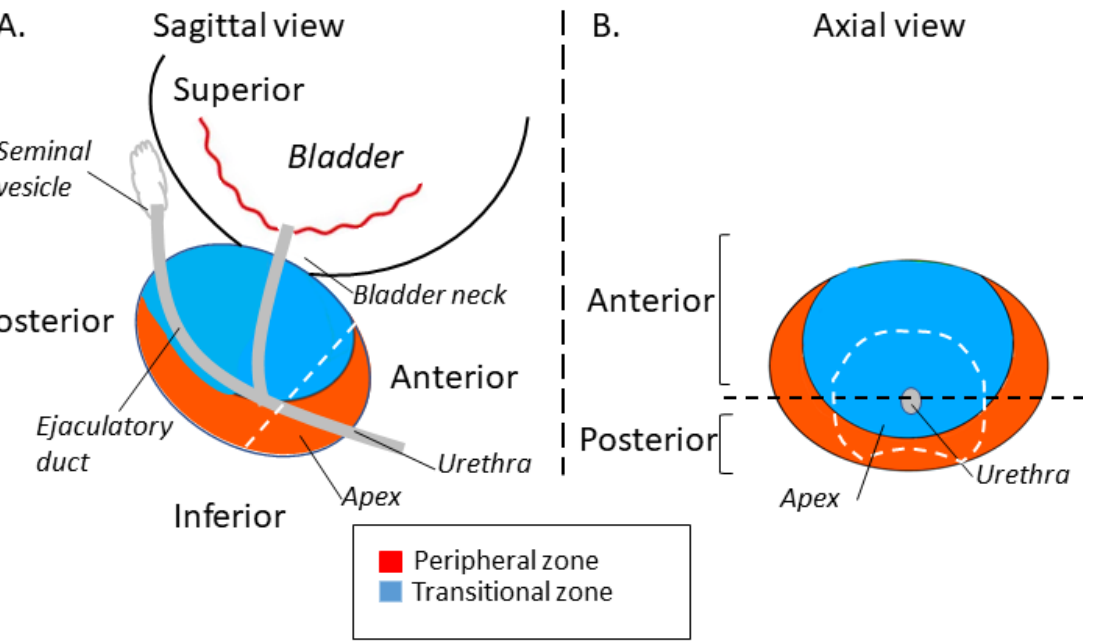
Figure 1. Schematic diagram of an anatomical division of the prostate. The location of the Anterior/Posterior and Peripheral/Transitional Zones are described. ( A ) Sagittal view. ( B ) Axial view.